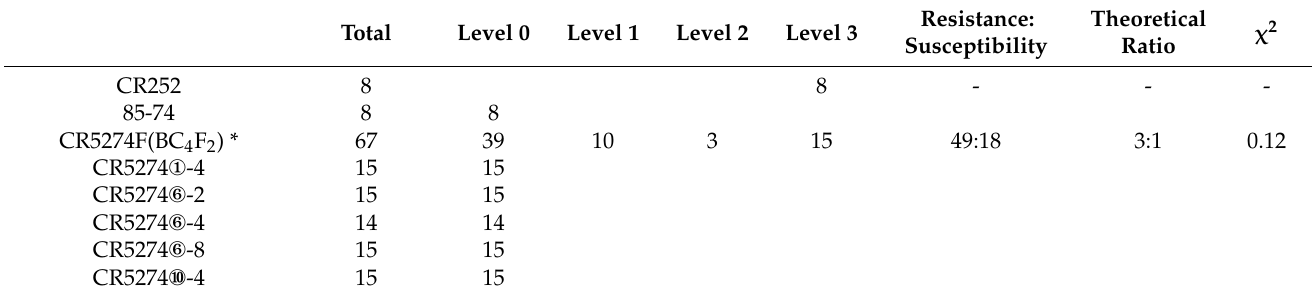
Table 4. Disease statistics of different populations in the field.